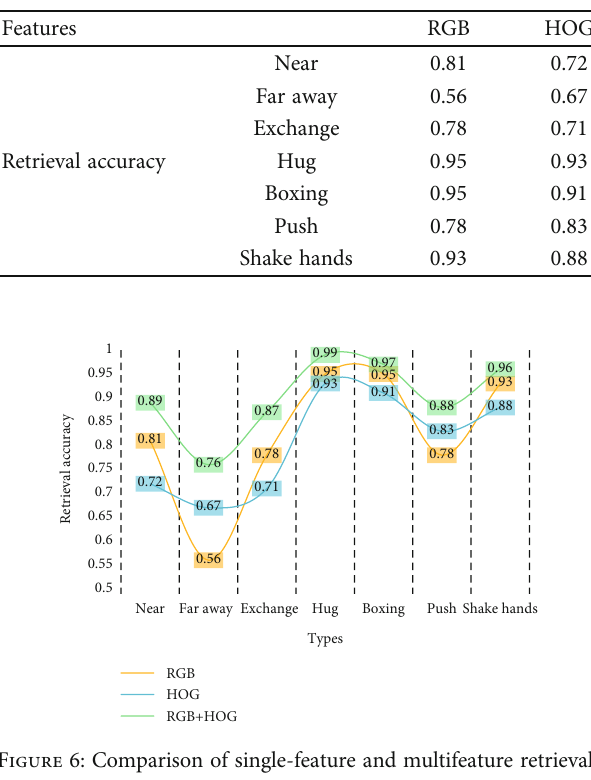
Table 1: Retrieval results of di ff erent